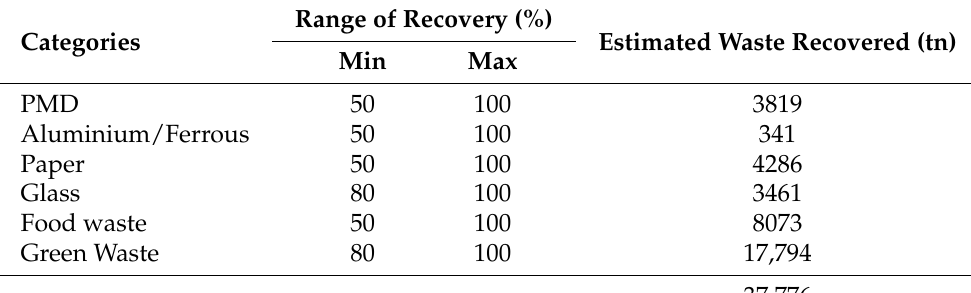
Table 4. Typical municipal solid waste recovery